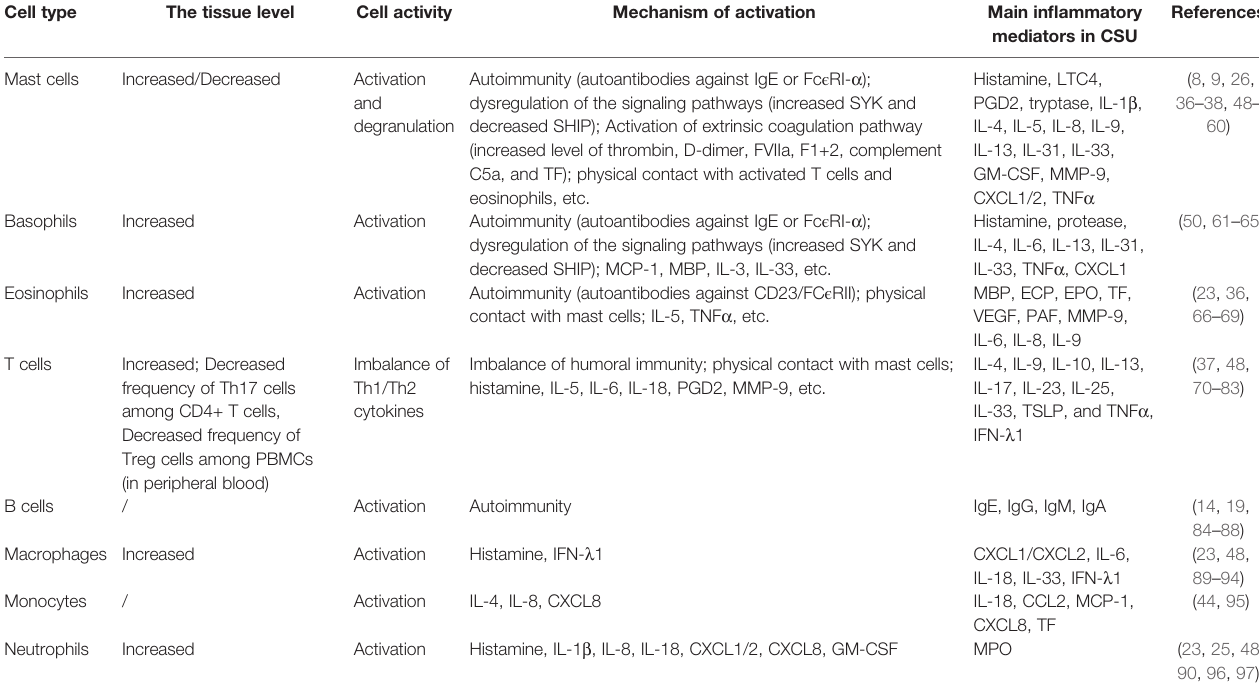
TABLE 1 | Immune cells involved in CSU.